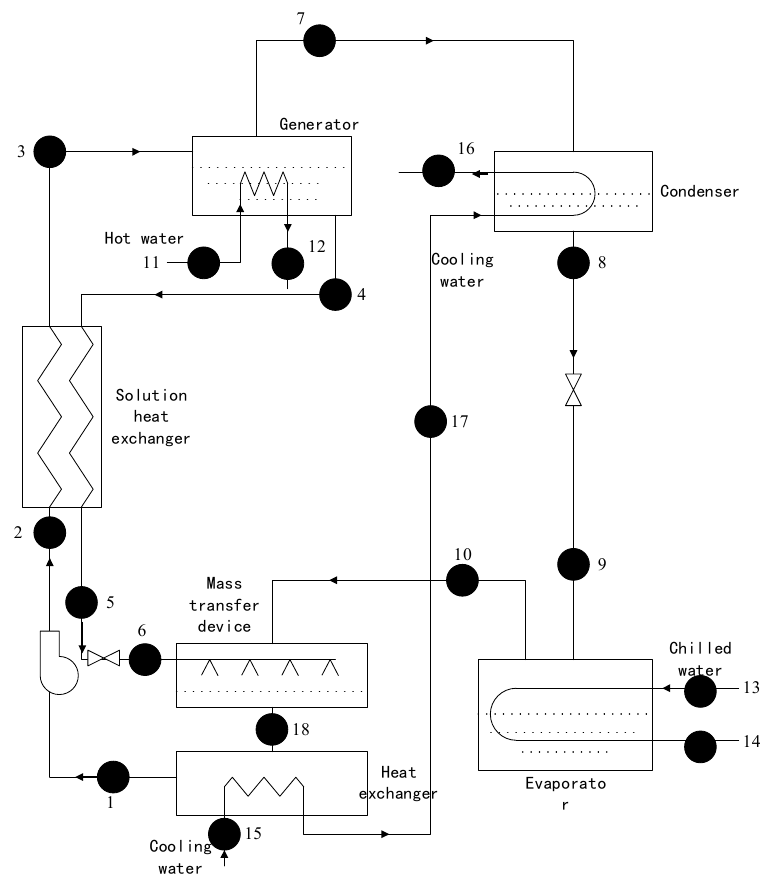
Figure 4. Single effect Li-Br absorption refrigeration cycle.